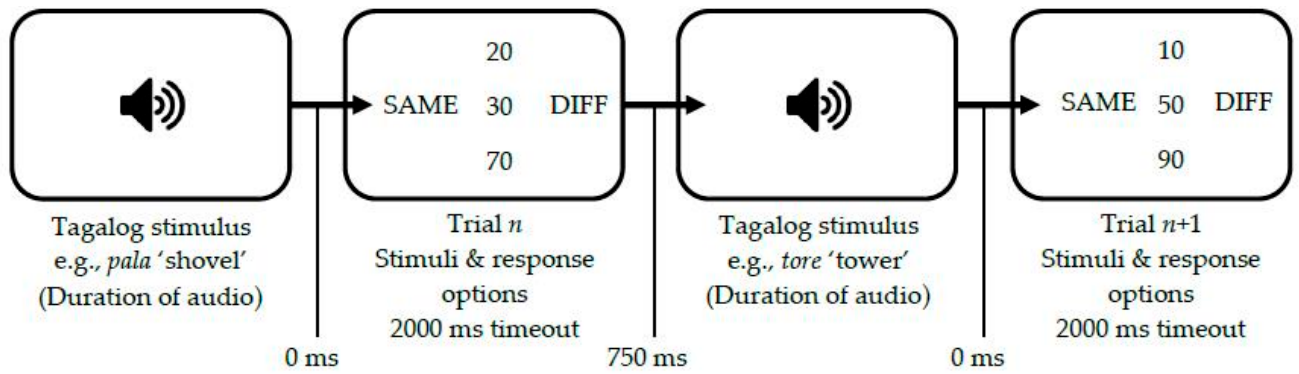
Figure 4. Trial design for condition 3a (unrelated task with interleaved FL exposure).